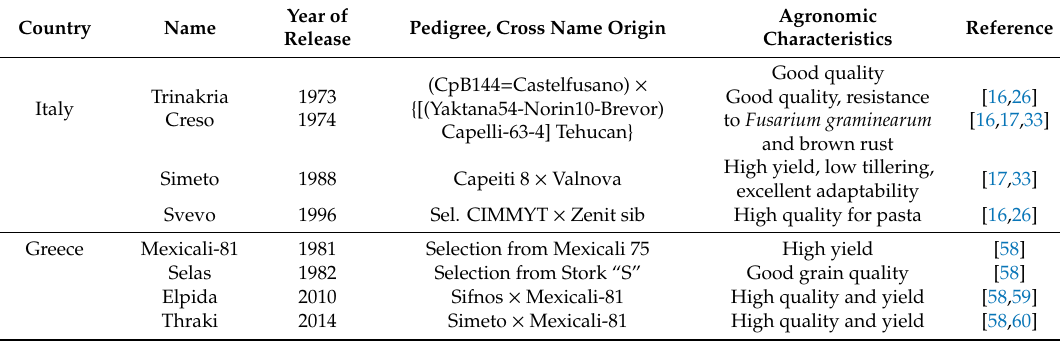
Table 4. The main Mediterranean cultivars released after the Green